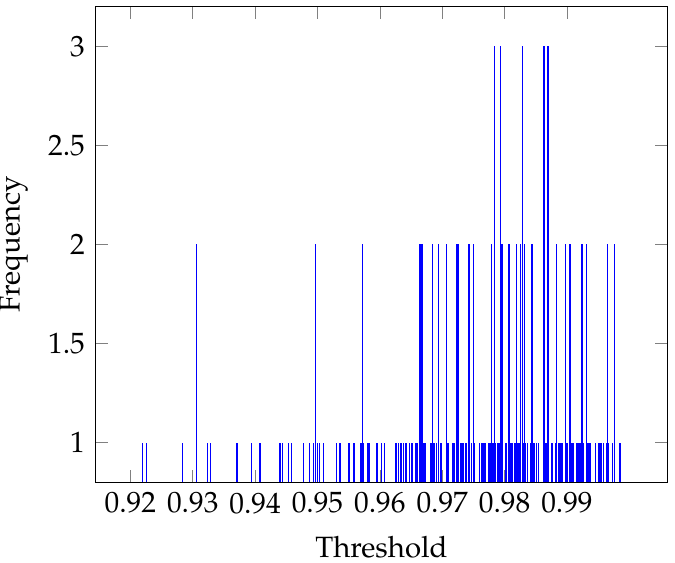
Figure 4. An adjacency matrix weight histogram for use in Otsu’s method. The data correspond to the β band (13–30 Hz) for the IM of the